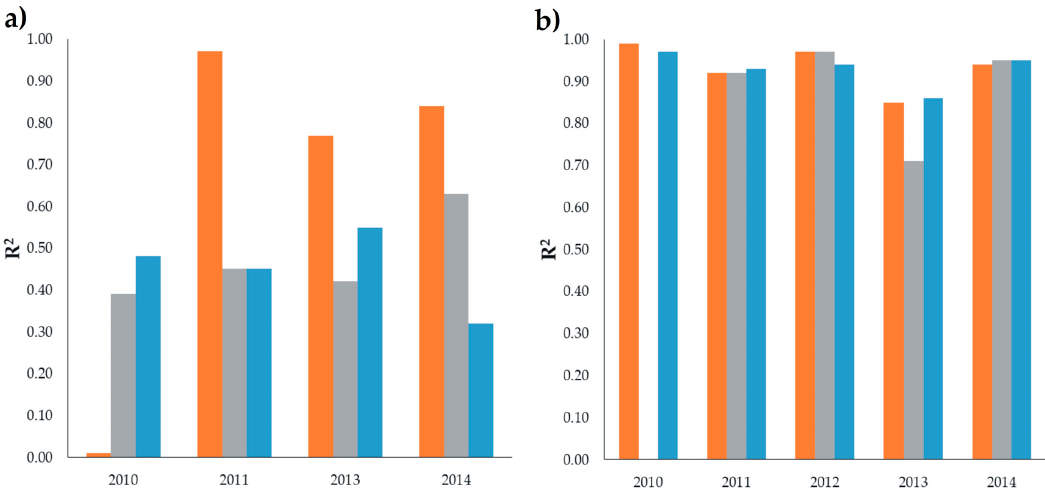
Eden ( a ); El Sitio ( b ); Teseachi ( c ); ATCOR2 ( — ), DOS1 ( — ) and FLAASH ( — ) through single band.